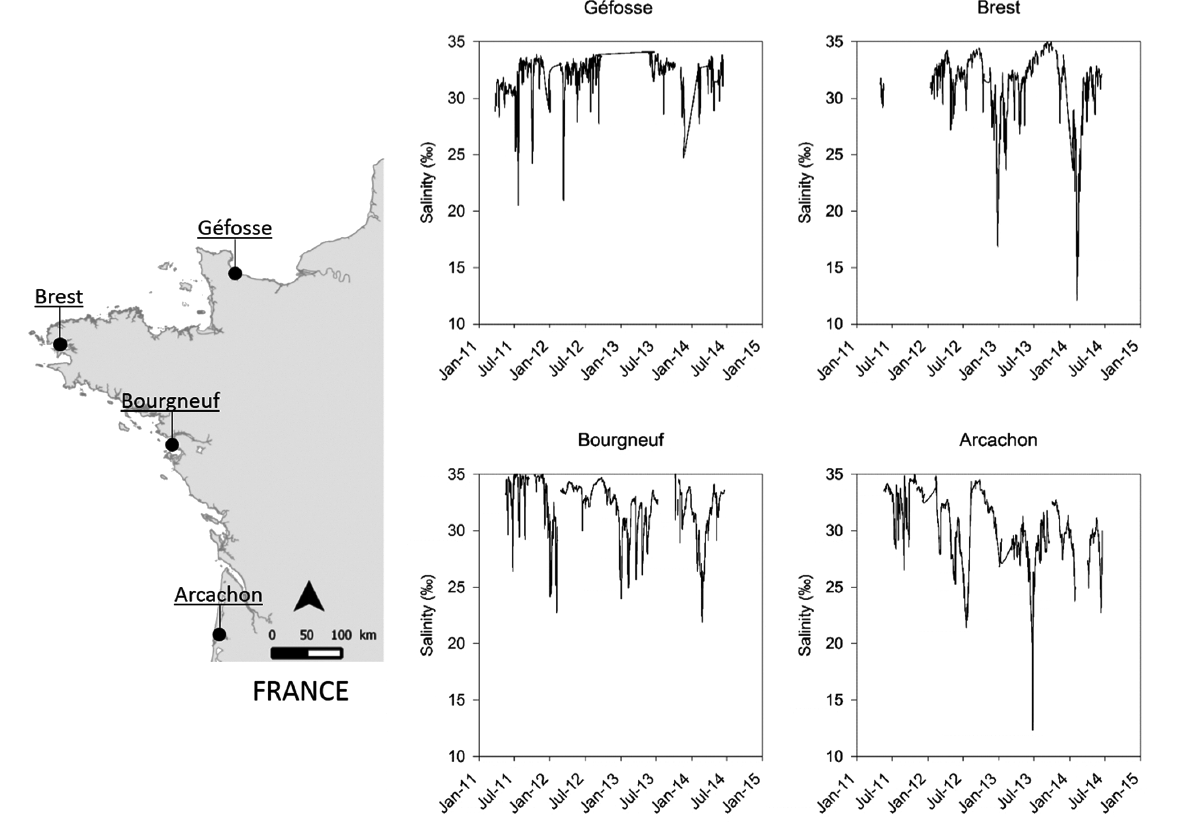
Fig. 1. Seawater salinities from January 2011 to June 2014 in 4 oyster farming areas along the French